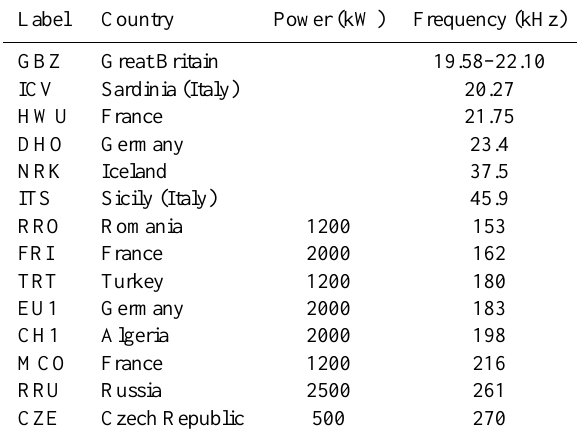
Table 2. Peculiarities of the VLF/LF transmitters of the European